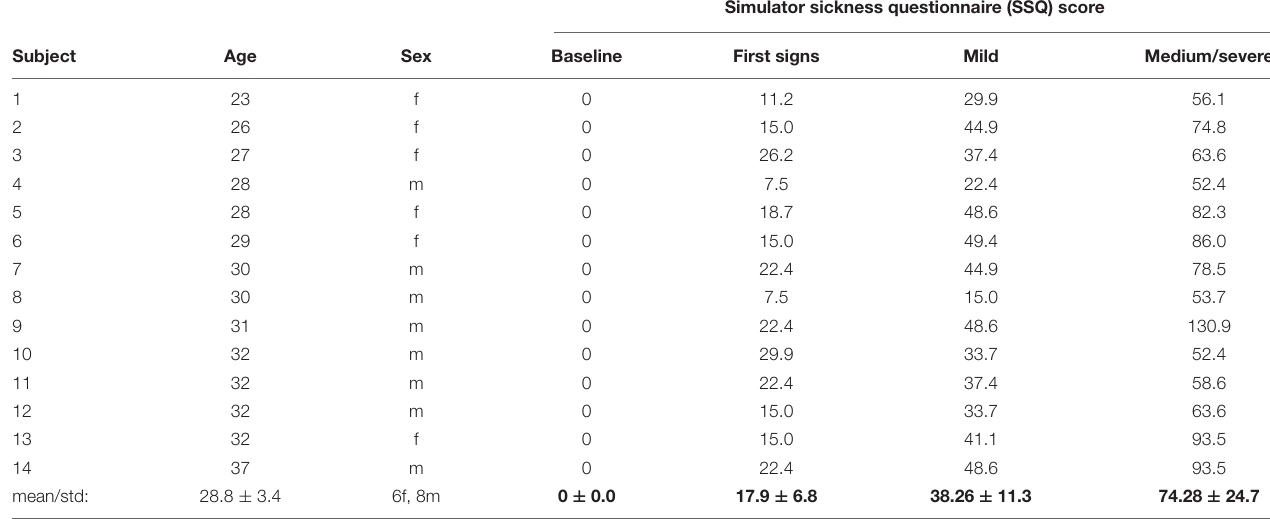
TABLE 1 | Participants and individual results of the simulator sickness questionnaire